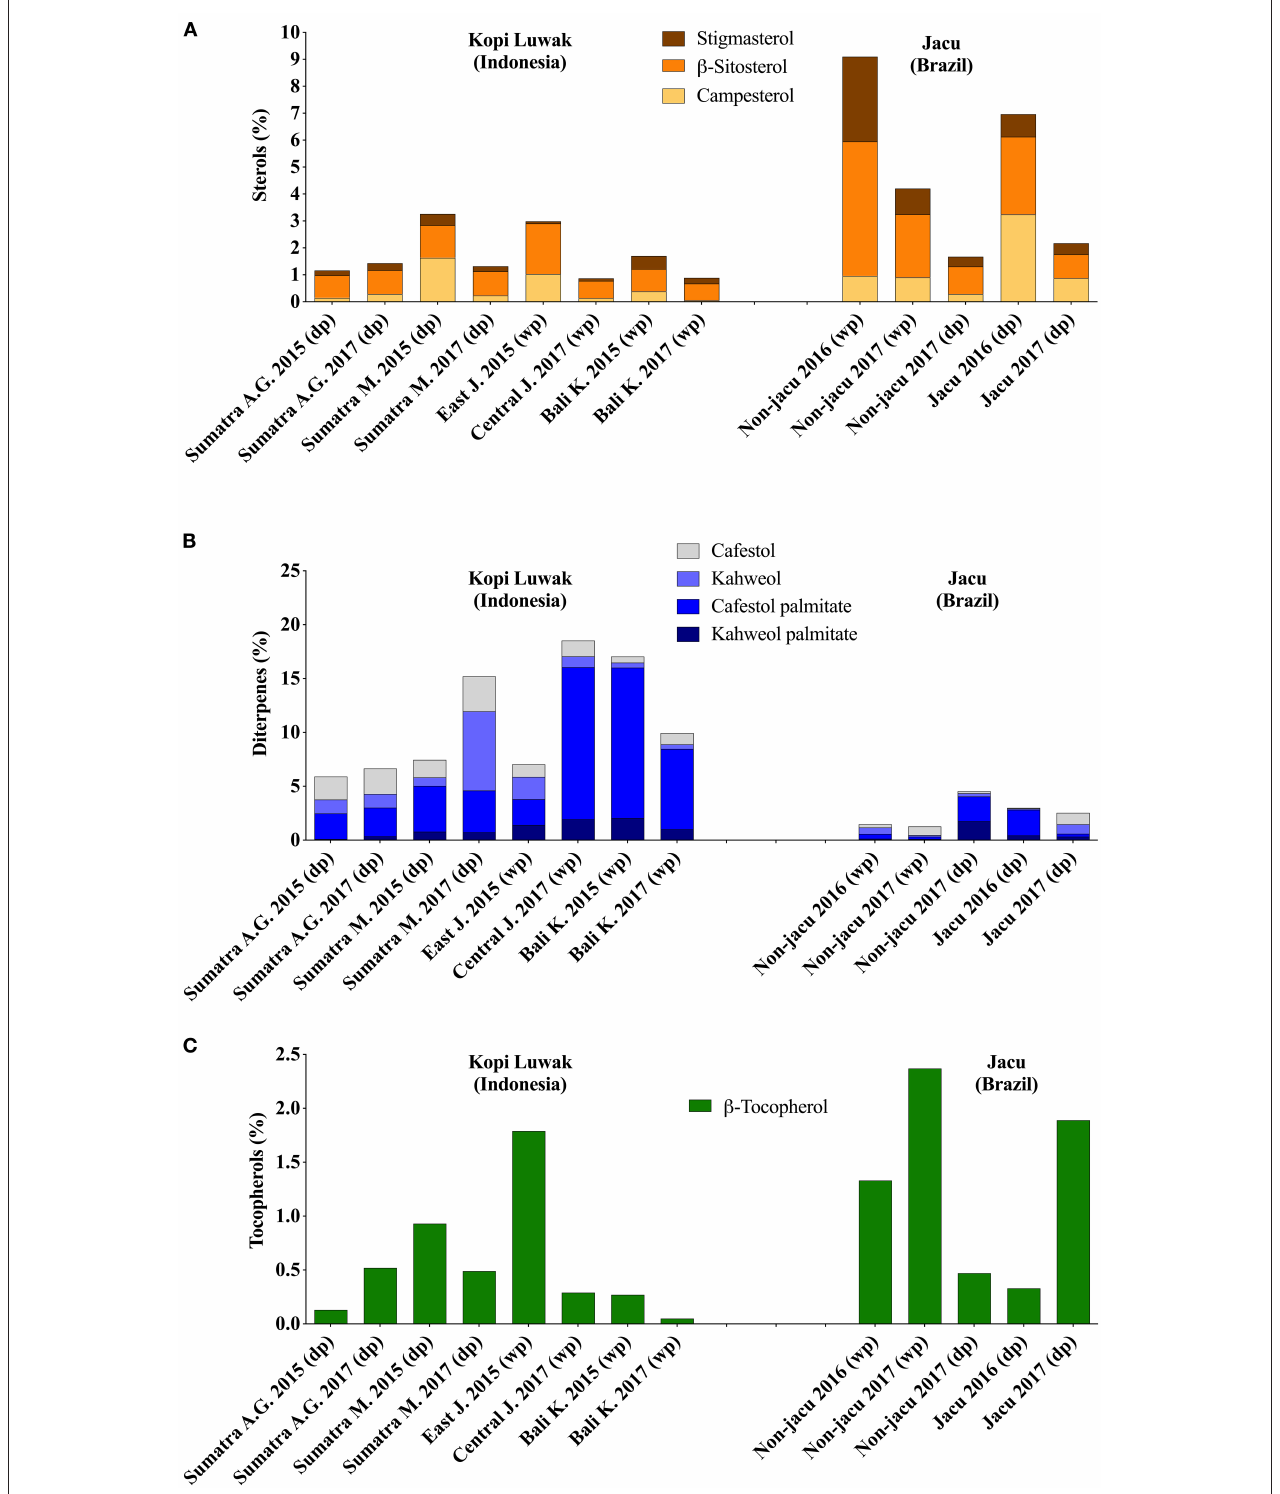
FIGURE 6 | Profile of sterols (A) , diterpenes (B) , and tocopherols (C) of coffees from Indonesia (Kopi Luwak) and Brazil (Non-jacu and Jacu). Indonesian samples were from 2015 and 2017 crops of different regions (A.G., Aceh Gayo; M., Mandheling; J., Java; K., Kintamani). Brazilian samples were from 2016 and 2017 crops. Samples were either dry processed (dp) or wet processed